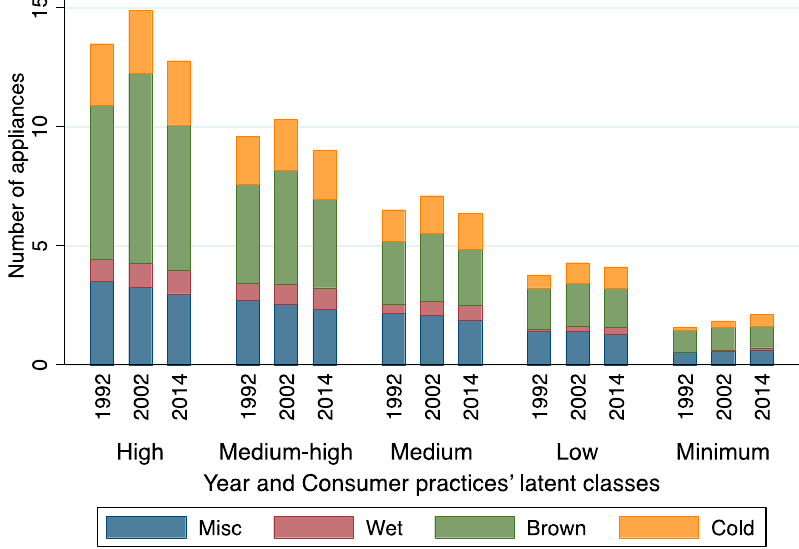
Figure 7. Number of appliances over consumer practices’ latent classes and end uses. Mexico, 1992, 2002, and 2014. Source: Authors’ calculations, ENIGH (1992–2014).